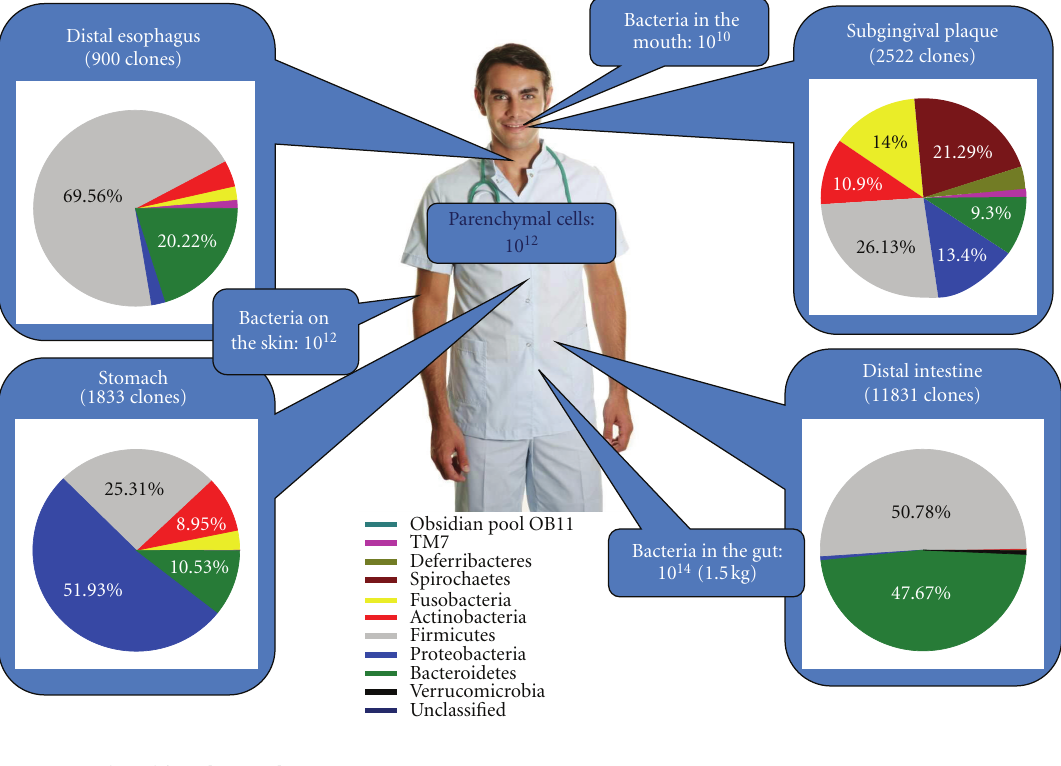
Figure 1: Association of the microbiota with humans. Microbiota presents in all parts of our body which has direct contact with external environment. The numbers of bacteria in the mouth (10 10 ), on the skin (10 12 ), and in the distal gut (10 14 ) are presented in a relation to total number of parenchymal cells (10 12 ). The composition of the microbiota in the digestive tract greatly di ff ers in each of specialized compartments as illustrated [6, 13–15]. Physiological functions and chemical environment of each compartment are likely key factors influencing the bacterial